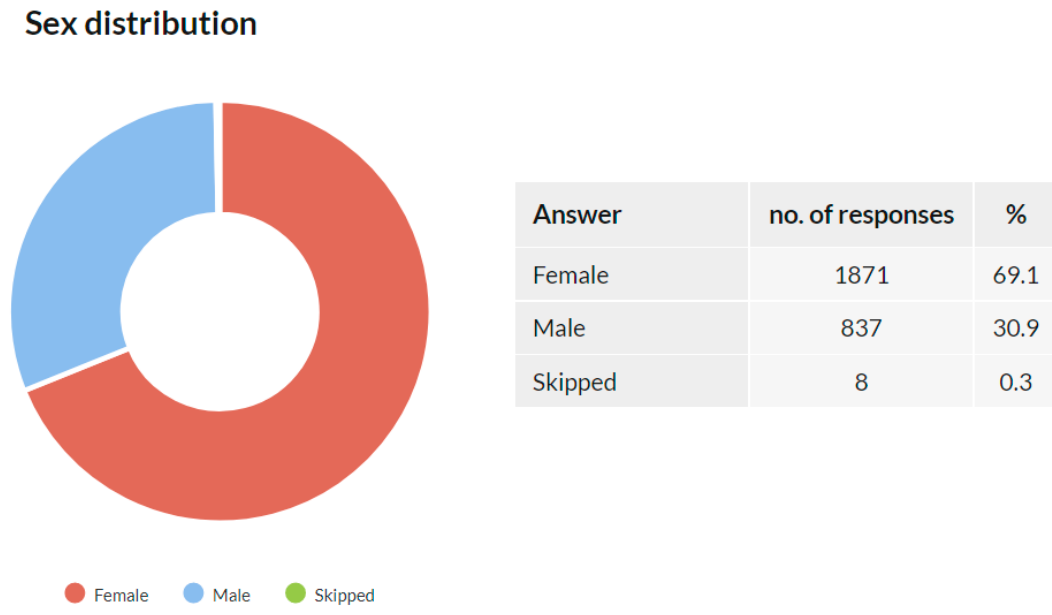
Figure 2. Sex distribution of the study participants.